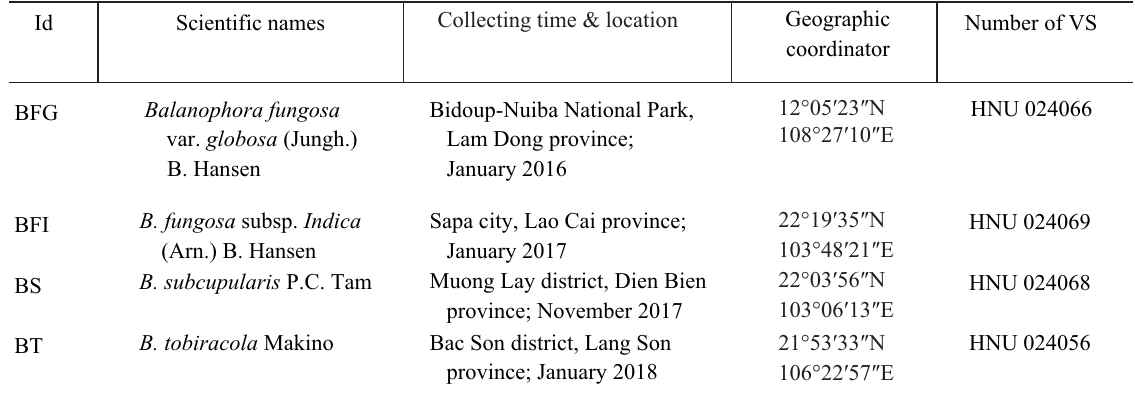
Table 1. Information of Balanophora